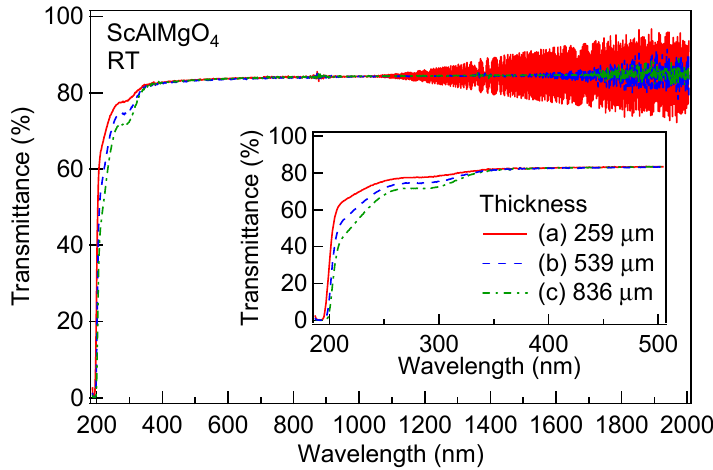
Figure 8. Room-temperature transmission spectra of SCAM substrates with the thickness of (a) 259 µm, (b) 539 µm, and (c) 836 µm. The inset figure was the expanded ultraviolet transmission spectra.